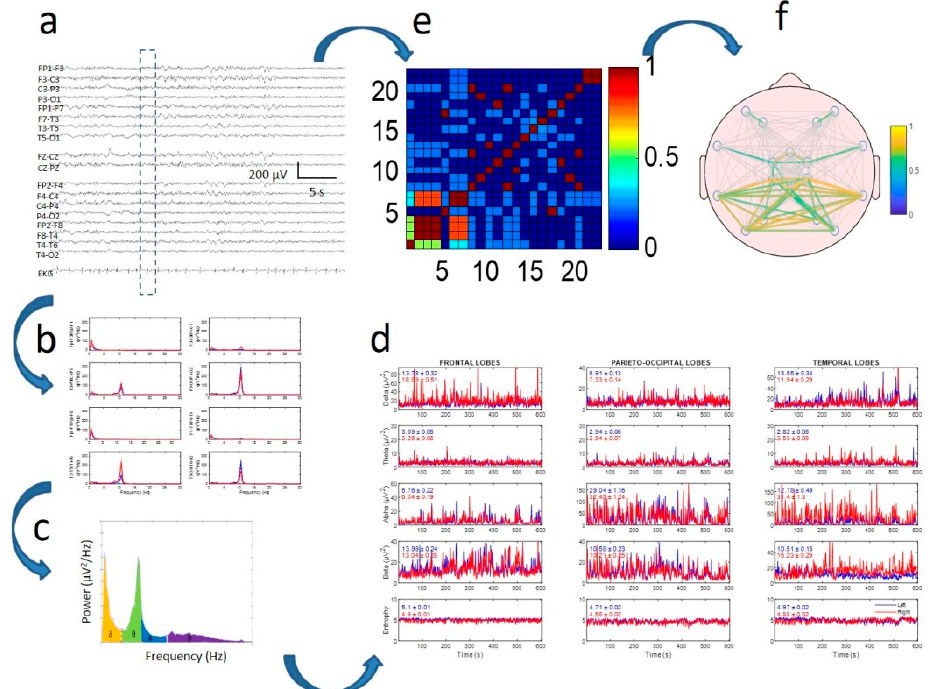
Figure 1. Method of electroencephalogram (EEG) quantification in two branches: power spectra ( b – d ) and synchronization ( e , f ). ( a ) Raw EEG tracing. Discontinuous rectangle shows moving window used for analysis; ( b ) power spectra for every channel; ( c ) areas for delta, theta, alpha, and beta bands under spectrum highlighted in different colors; ( d ) dynamics of four bands (and entropy in lower row) for every lobe. Mean and standard error of the mean (SEM) values for every tracing are displayed inside every graph. Red and blue lines indicate right and left hemispheres, respectively; ( e ) correlation matrix for window; ( f ) mean correlation computed for all recordings.